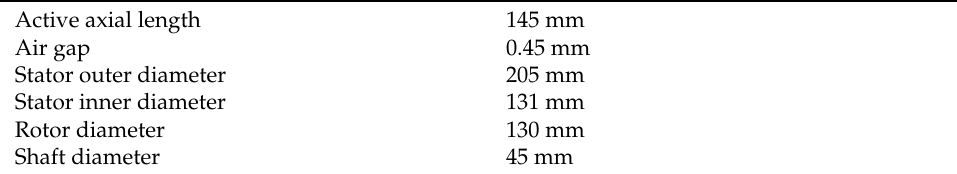
Figure 8. Mechanical coupling of the SynRM with induction machine ( left ), SynRM in a test bench ( right ) . Table 2. SynRM’s main dimensions . Table 2. SynRM’s main dimensions.